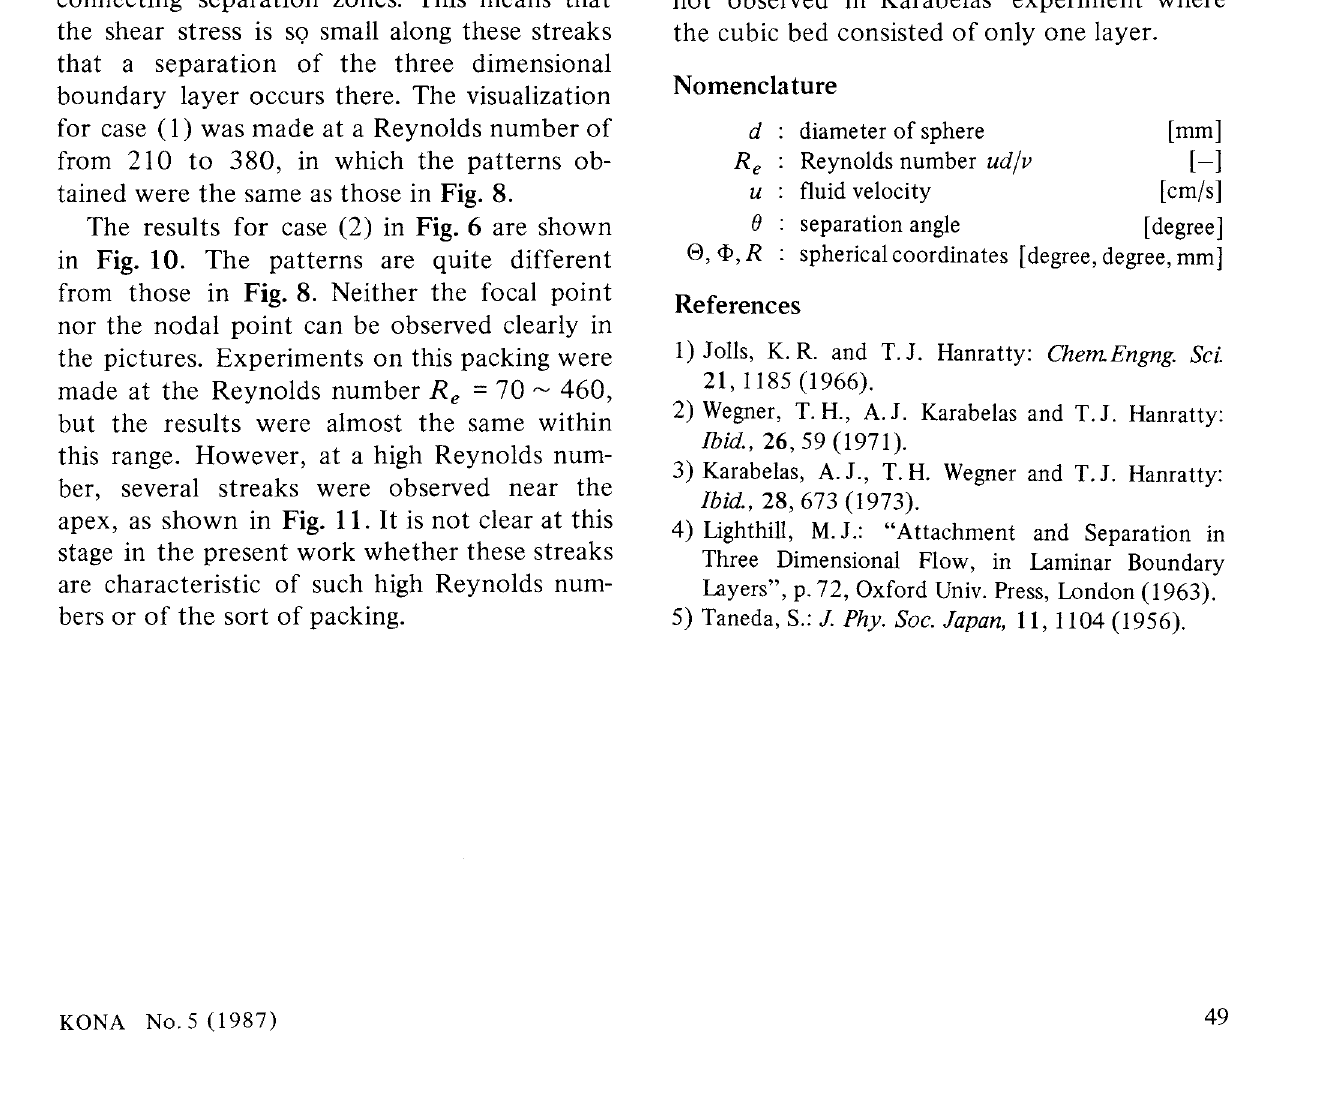
Fig. 11 Visualized result near the top of the sphere (The central part is a scar due to the string.)